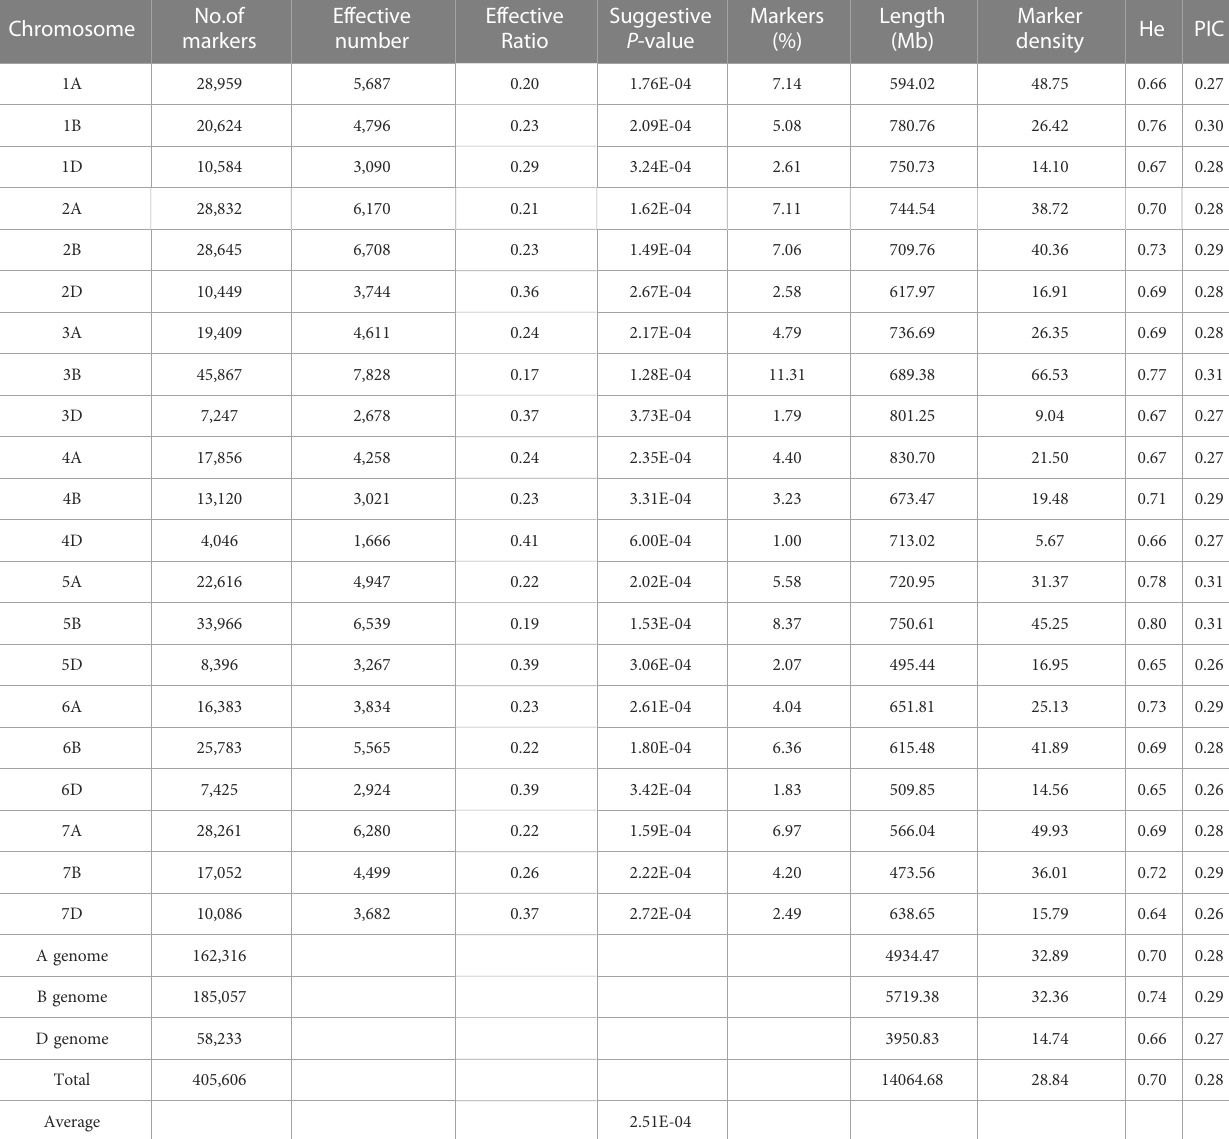
TABLE 3 Summary of the SNPs information in three sub-genomes and chromosomes of 382 wheat accessions.